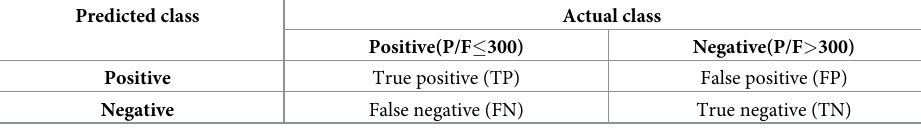
Table 1. The relationship between real categories and recognition